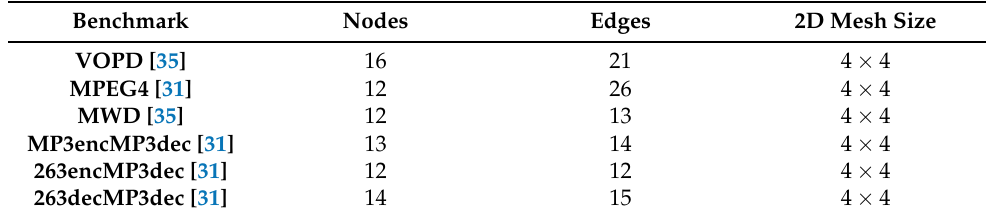
Table 1. Standard NoC benchmarks details with mesh sizes.